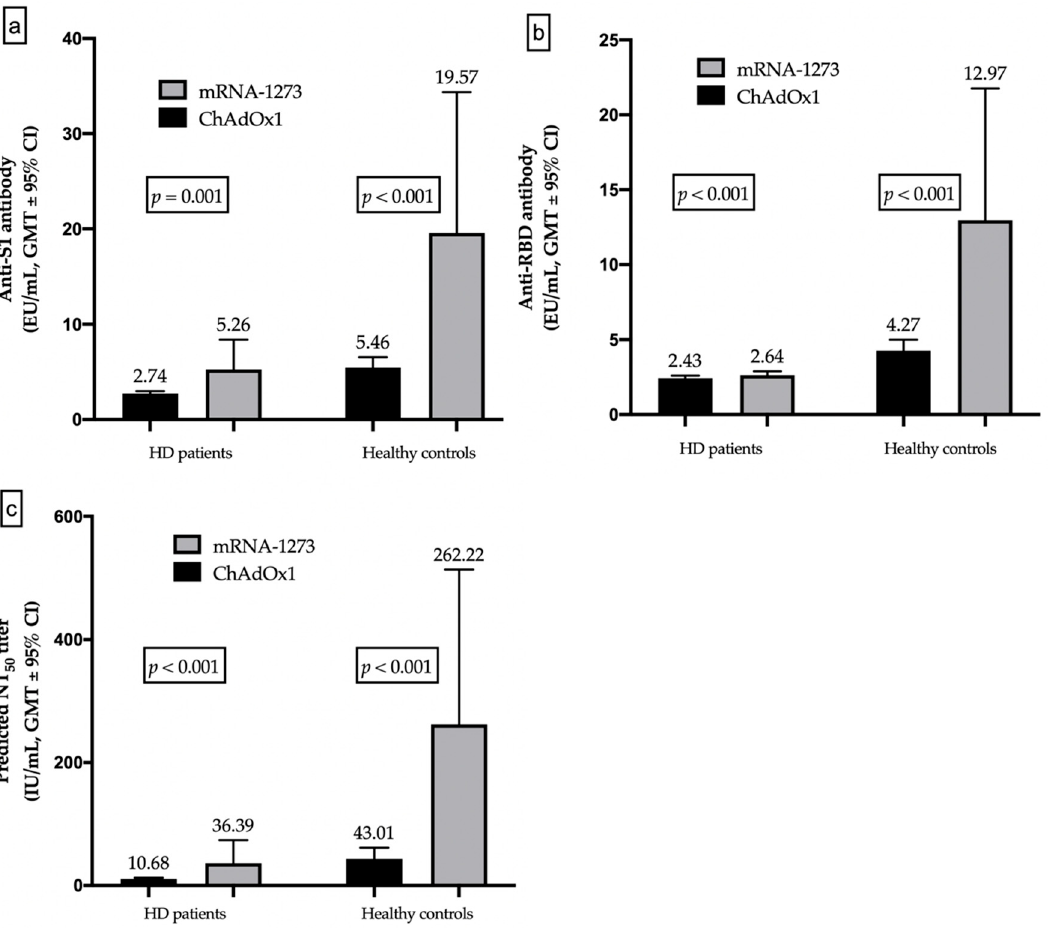
Figure 4. Comparison of humoral responses between ChAdOx1- and mRNA-1273-vaccinated individuals: ( a ) Geometric mean titers (GMTs) of anti-S1 antibodies; ( b ) GMTs of anti-receptor-binding-domain (RBD) antibodies; ( c ) GMTs of predicted SARS-CoV-2 50% neutralization titer (NT 50 ).